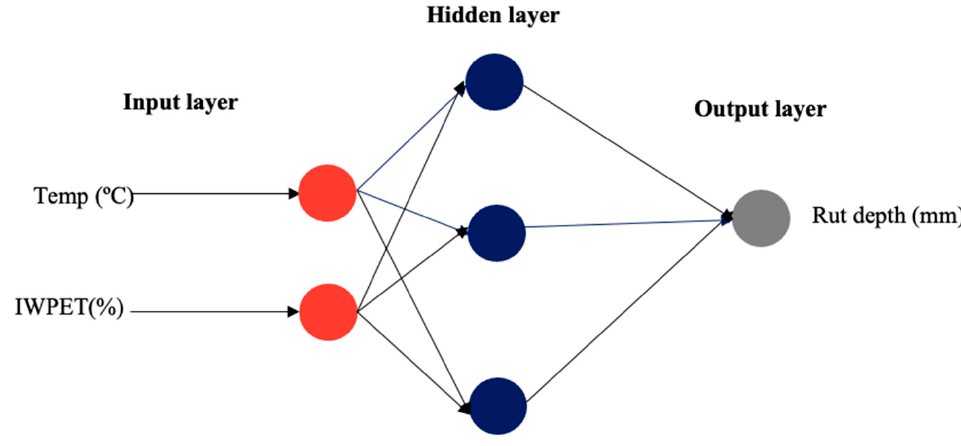
Figure 15. ANN topology for the stiffness modulus response of the modified asphalt mix.